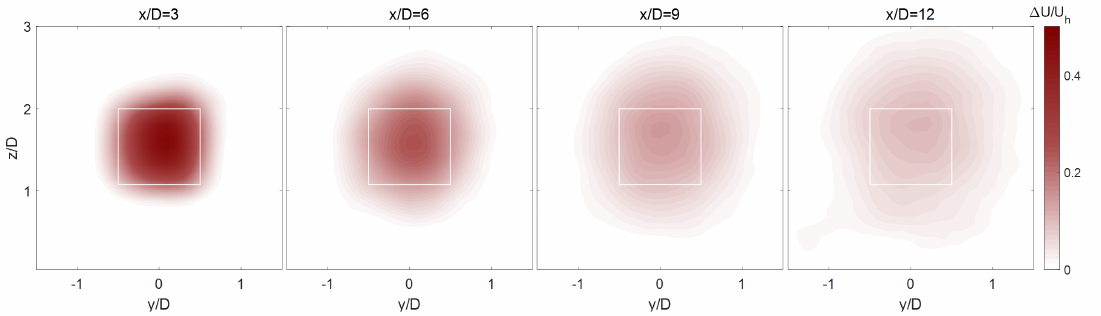
Figure 7. Contours of the normalized velocity defect in the cross-sectional planes downwind of the turbine for Case (1) obtained from the LES. The turbine location is represented with the white rectangle.